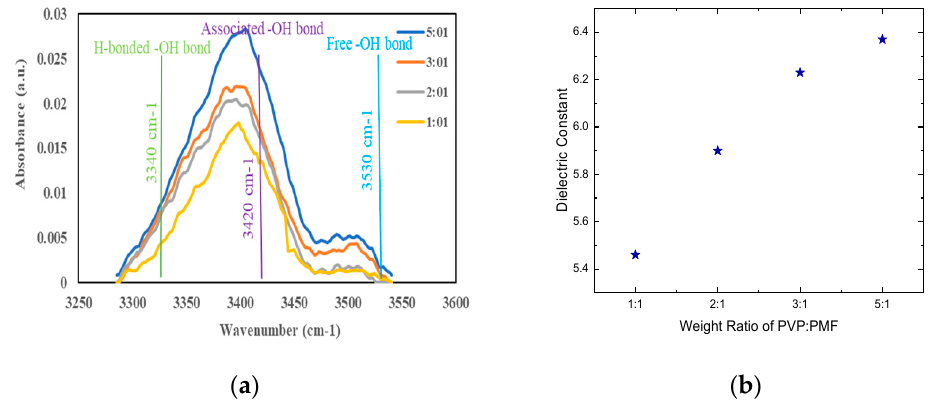
Figure 3. ( a ) FTIR spectra. ( b ) Dielectric constant of PVP-PMF dielectrics at various weight ratios .